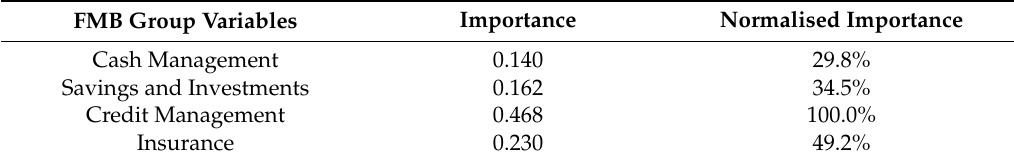
Table 3. Independent variable importance for Model A (calculated by the authors).